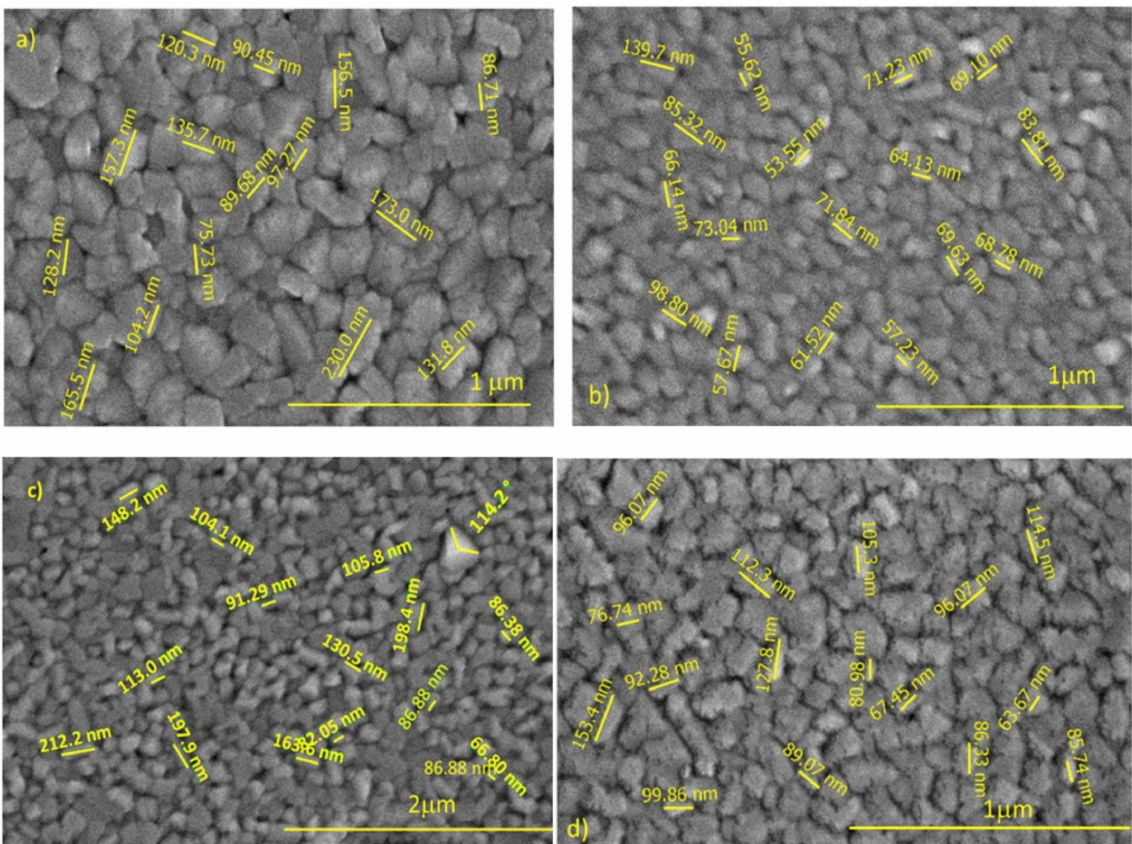
Figure 4. SEM image of the WO 3 layer grown at 4 h deposition time and various temperatures. ( a ) T = 600 ◦ C; ( b ) T = 660 ◦ C; ( c ) T = 680 ◦ C and ( d ) T = 700 ◦